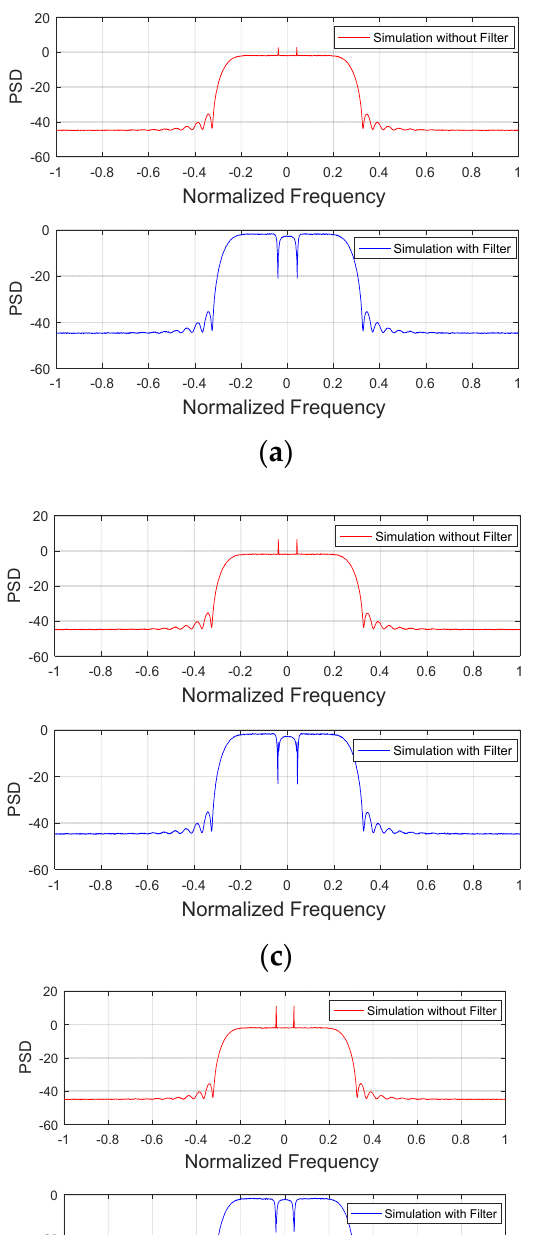
16 of 20 Figure 19. SNR vs. JSR, with Eb/No = 20 dB.